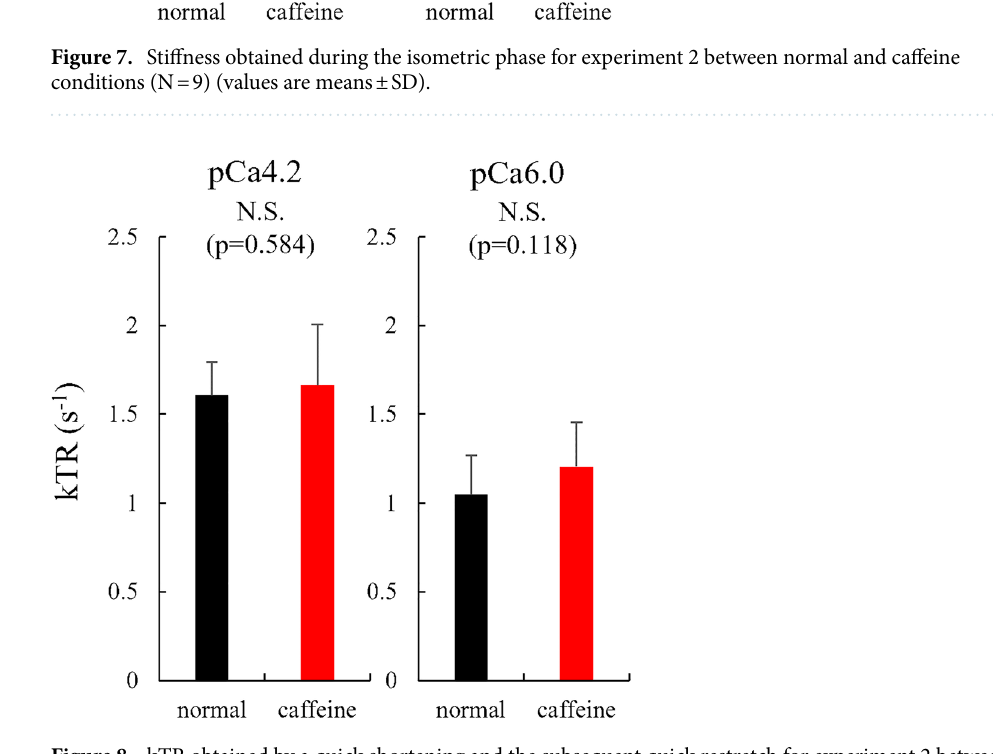
Figure 8. kTR obtained by a quick shortening and the subsequent quick restretch for experiment 2 between normal and caffeine conditions (N = 9) (values are means ±